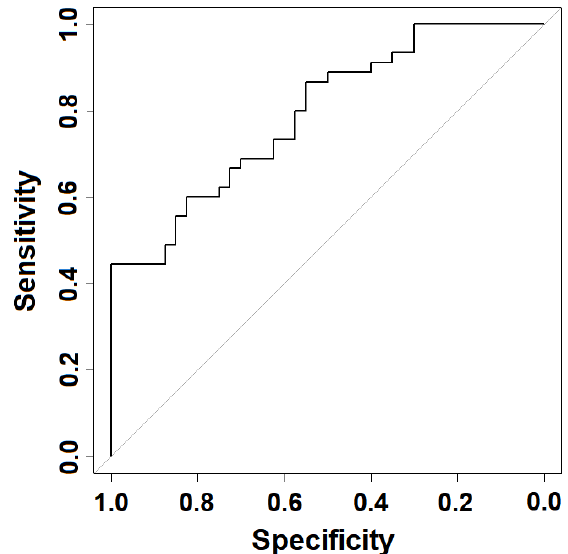
Figure 4. Receiver operating characteristic (ROC) curve illustrating the statistical performance of model 3 for calculating the thermal liquid biopsy (TLB)